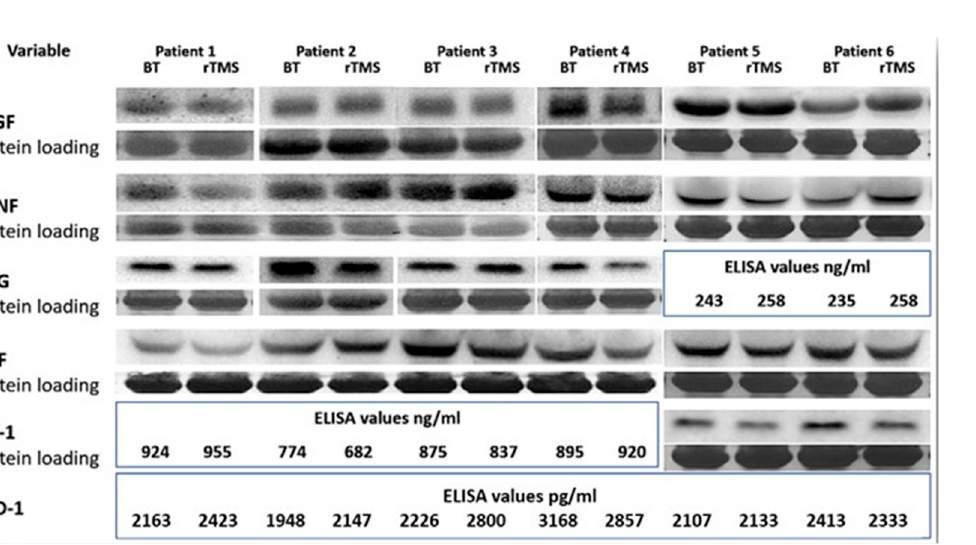
Figure 5. Representative Western blot images and ELISA measurements showing changes of se- lected growth factors compared to the samples before treatment. ANG: angiogenin; BDNF: brain- derived neurotrophic factor; BT: before treatment; ELISA: enzyme-linked immunosorbent assay; END-1: endothelin-1; IGF-1: insulin-like growth factor-1; NGF: nerve growth factor; rTMS: after treatment with repetitive transcranial magnetic stimulation; VEGF: vascular endothelial growth fac-